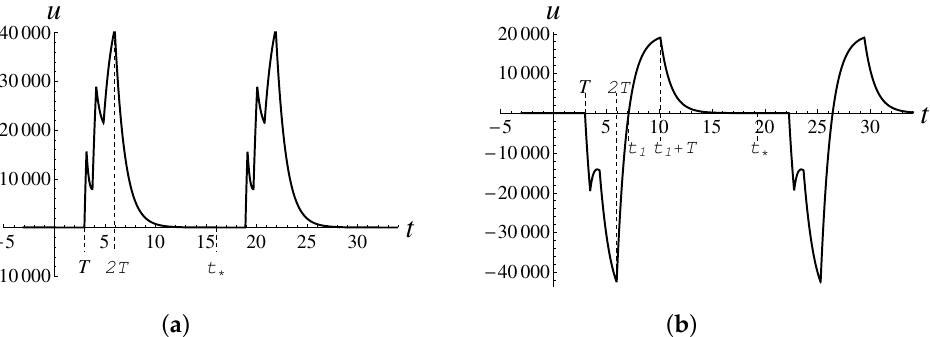
Figure 4. Relaxation cycles of Equation (2) in the case that b > 0 and d = 0; function f ( u ) satisfies the condition ( a ) (27) ( b ) (30). Values of parameters: λ = 10 4 , T = 3, p L = − 1, p R = 2, b = 2, and d =